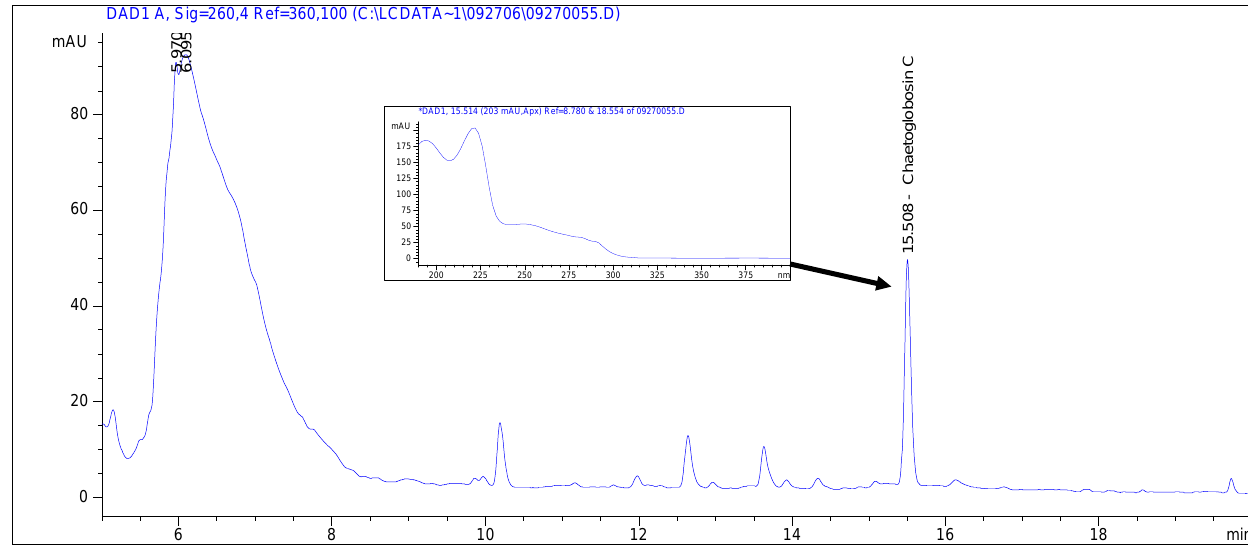
Figure 3. HPLC chromatogram with UV spectra of selected peak inserted. The chromatogram shows the signal obtained from the methanol extract of C. globosum grown on five citrate phosphate buffered potato dextrose agar plates at a pH of 7.01 for four weeks. The retention times (min) are plotted on the x-axis and the peak sizes (in milli- absorbance units) on the y-axis. For UV spectrum (inset), wavelengths (in nanometers) are plotted on the x-axis and peak sizes (in milli-absorbance units) on the